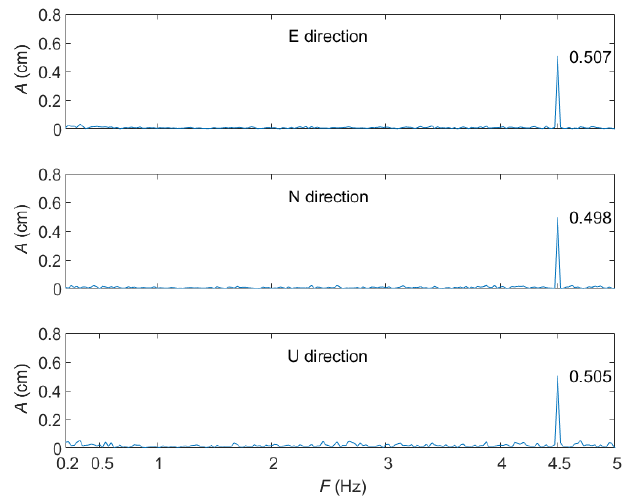
Figure 13. FFT spectrum of the low-frequency vibrational behavior ( A = 0.5 cm, F = 0.5 Hz).